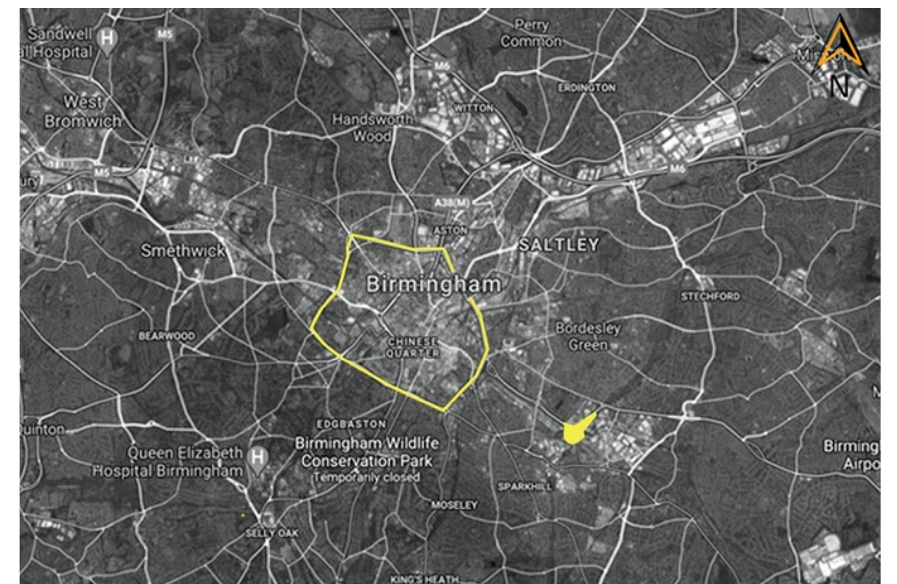
Figure 2. The Lost World in relation to Birmingham city centre.